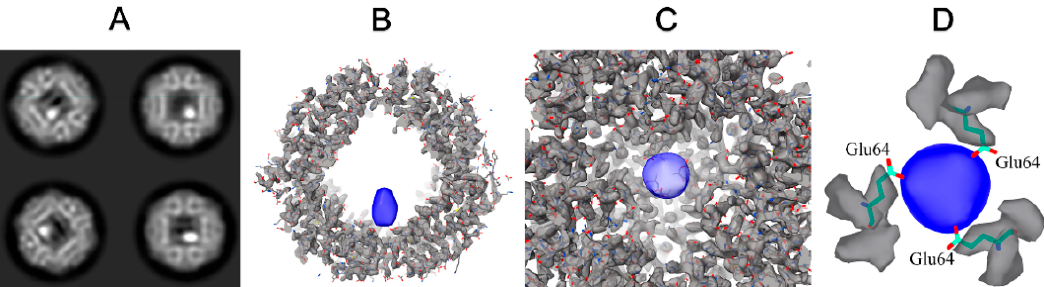
Figure 5. Dps-iron complex. ( A ) Example of 2D classification results; white dots correspond to iron clusters. ( B – D ) Cryo-EM map (EMD-12961); blue indicates the iron cluster and gray the Dps particle.